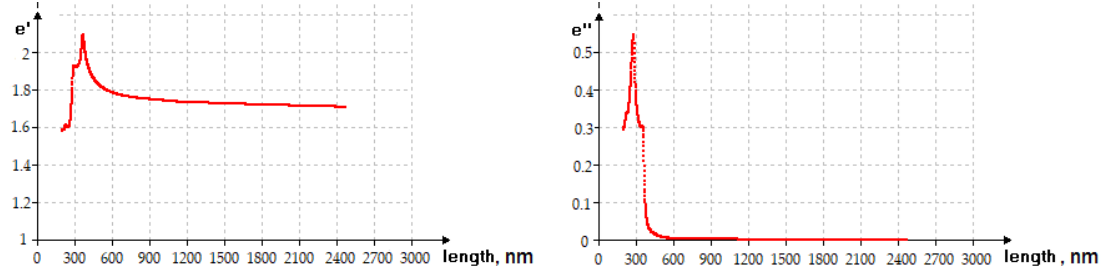
Figure 3. Dependence of the complex dielectric constant on the wavelength of electromagnetic ra- diation .